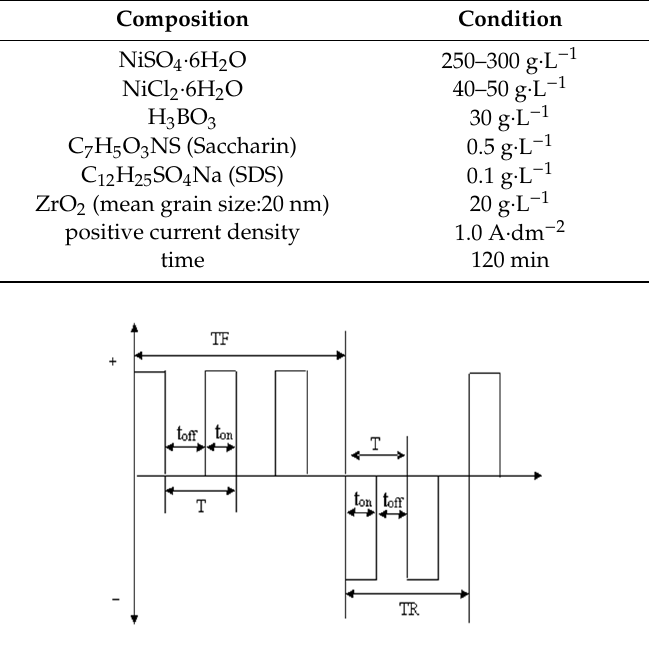
Figure 2. Waveform diagram of reverse pulse power.